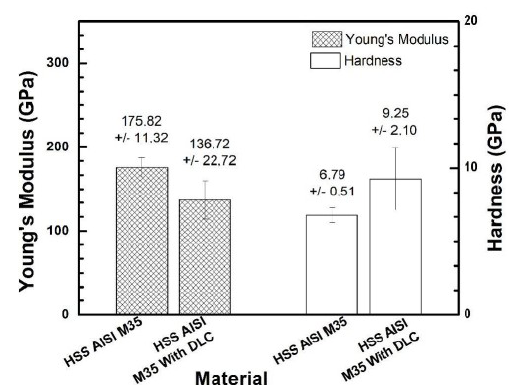
Figure 7. Results of nano-hardness and Young’s modulus of AISI M35 HSS and DLC